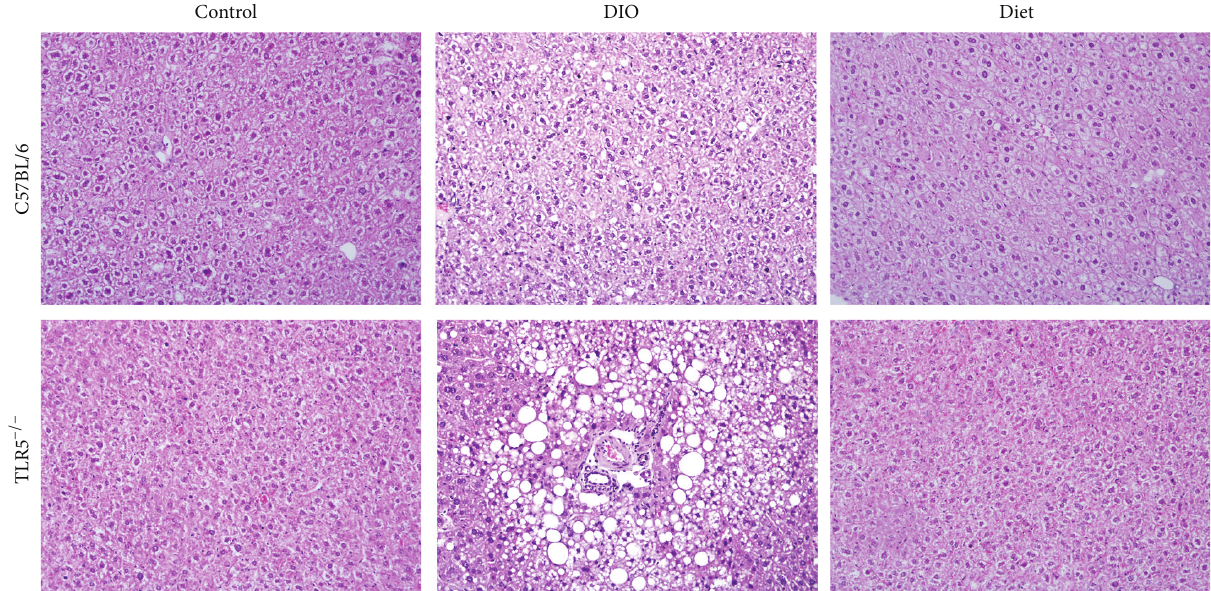
Figure 4: Hepatic steatosis in the hematoxylin and eosin stain of the paraffin-embedded liver at 5 𝜇 m section of C57BL/6 and TLR5 −/− mice in groups of control, DIO, diet at week